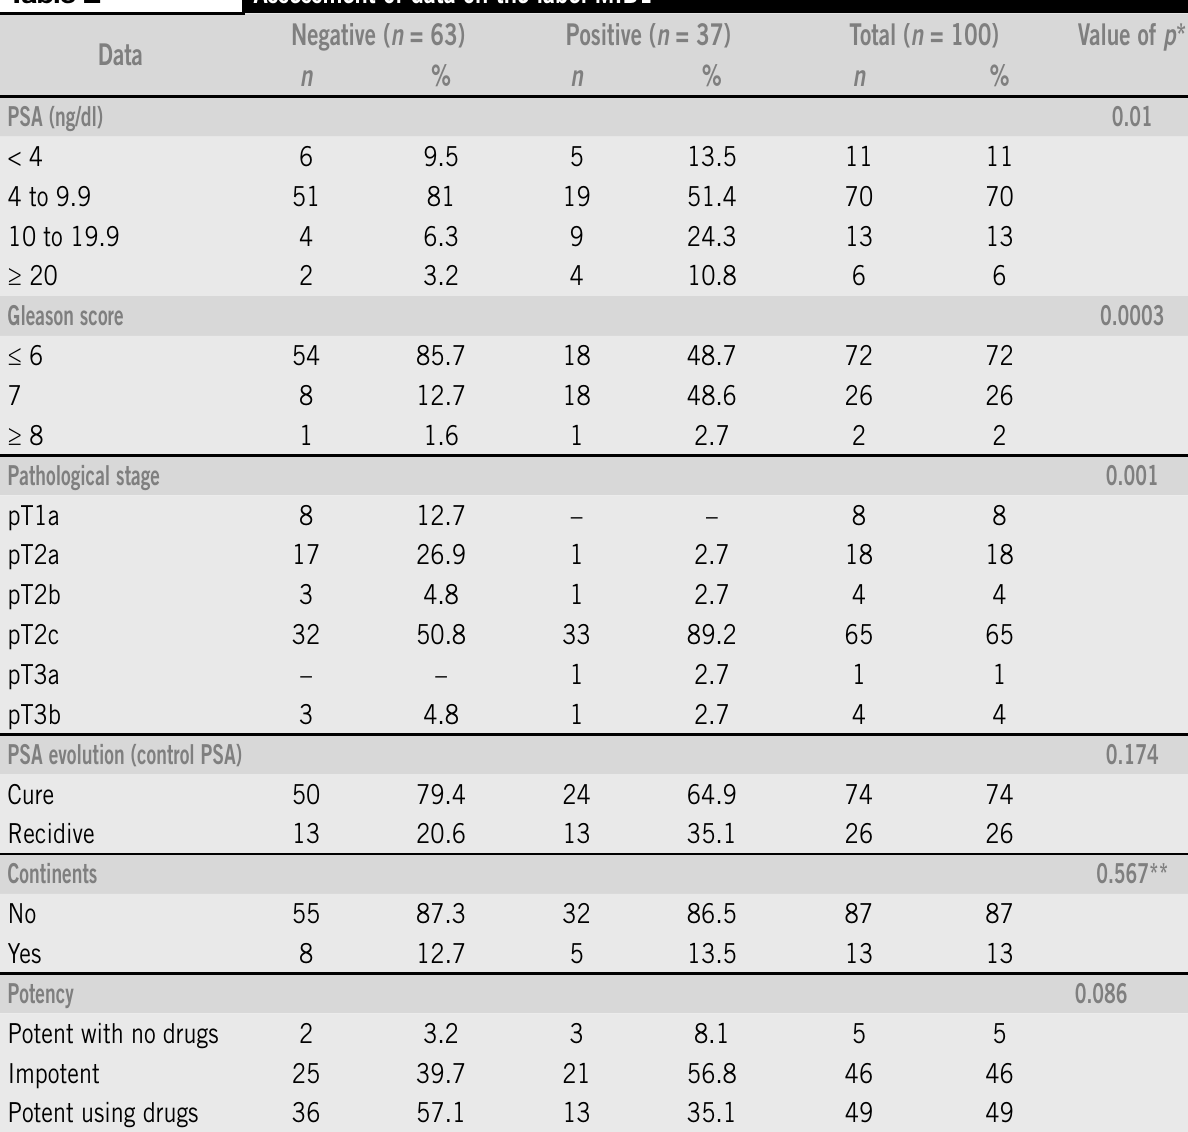
Table 2 Assessment of data on the label